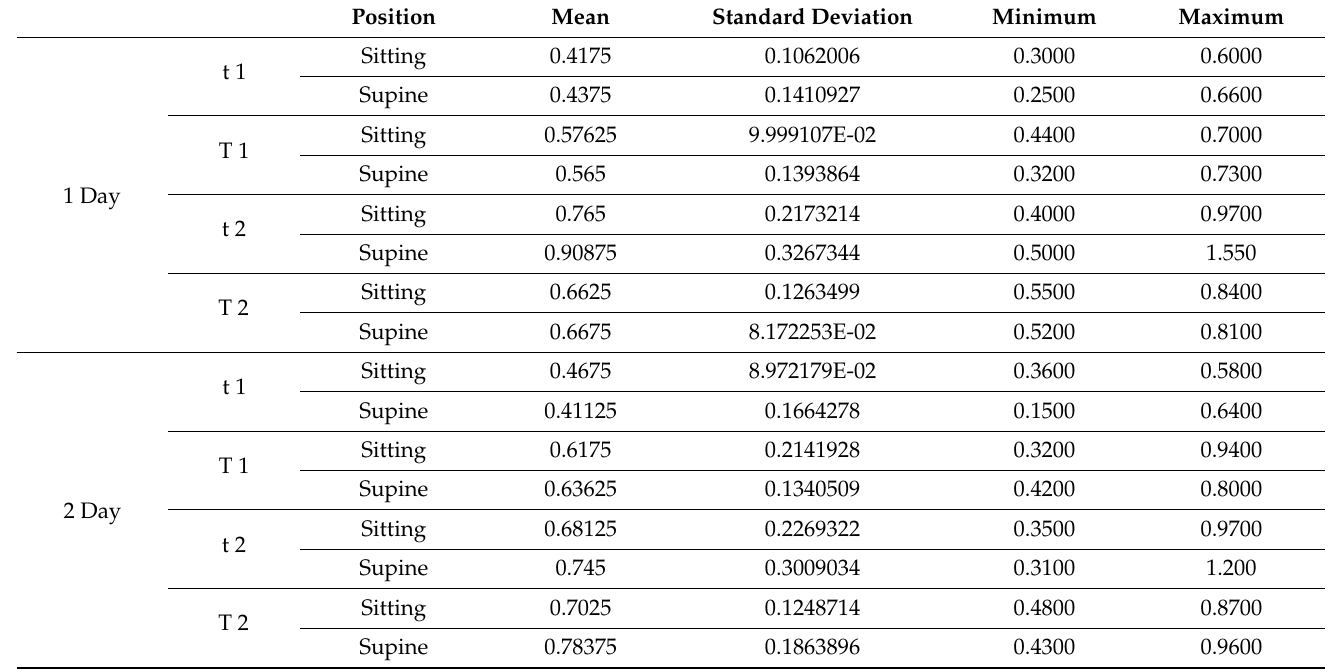
Table 1. Descriptive statistics of the obtained values.